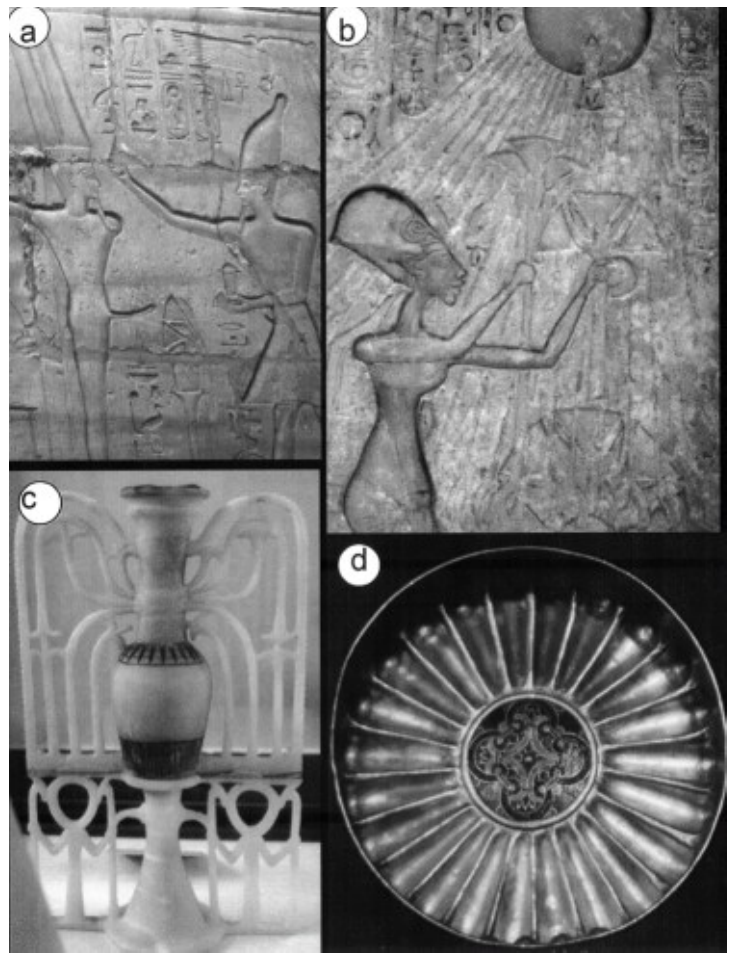
Figure 7. Lotus extracts in funerary rituals. ( a ) A lotus-libation scene at Luxor suggests that the king partook of a libation that was identified with the semen of the sun/lotus god, Min (an aspect of Amen). Karnak, 13th c. BCE. ( b ) The famous heretical sun worshipper, Akhenaten, enjoys the breath of eternal life (ankh to nose) as he upholds lotus blossoms to the sun during a libation ritual. El Amarna, 14th century BCE (Cairo Museum). ( c ) The contents of unguent vessels in the tombs of Egyptian kings were often identified with lotus stalks and flowers, life (ankh motifs), and everlasting sovereignty over Upper and Lower Egypt (sema-taui symbol). Thebes, Valley of the Kings, Tomb of Tutankhamen, 14th c. BCE (Cairo Museum). ( d ) Libation cups and goblets in Egypt and the Middle East were often decorated with, or depicted as, lotus blossoms. Tanis, Tomb of Psusennes I, 10th c. BCE (Cairo Museum).